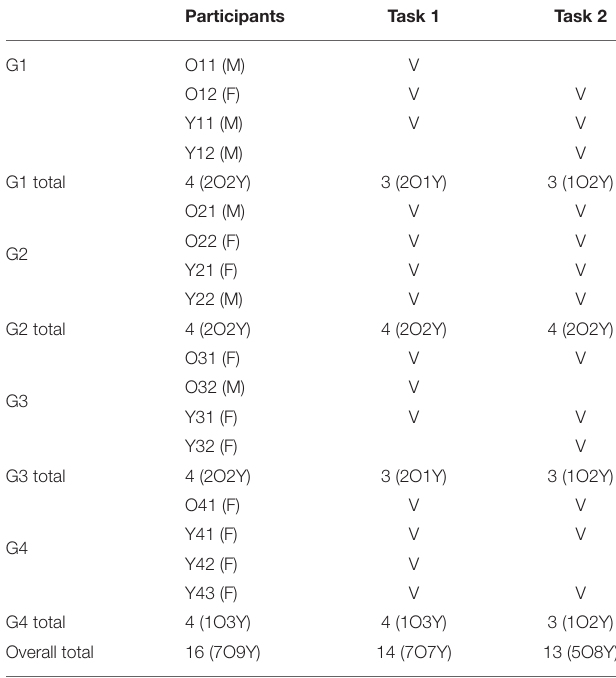
TABLE 1 | Participants in each group performing two collaborative